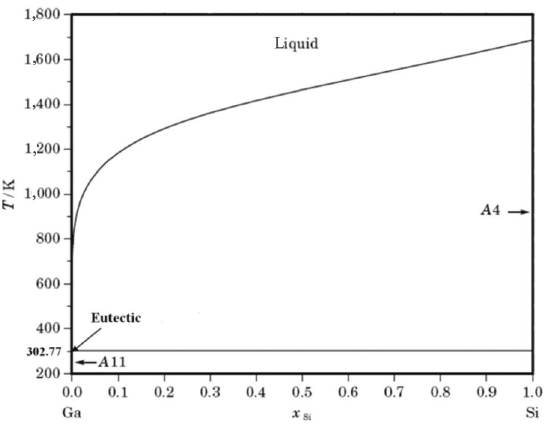
Figure 1: Ga – Si binary phase diagram.